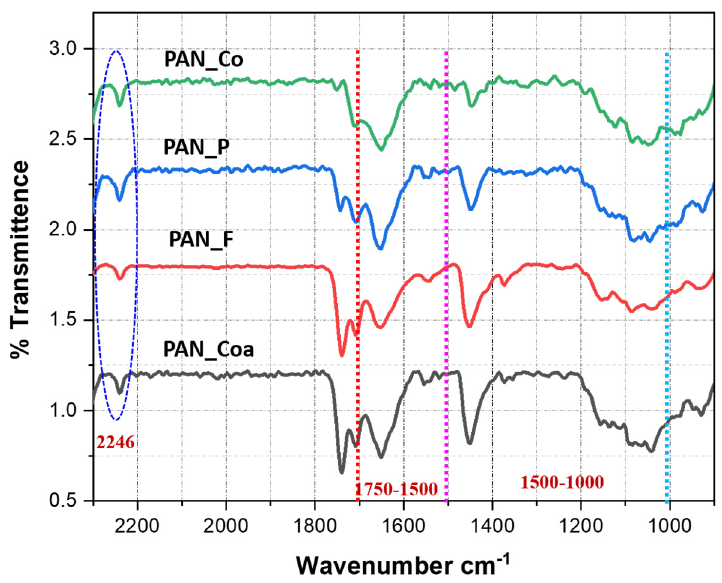
Figure 3. ATR-IR spectra of the PAN_P, PAN-F, PAN-Co and PAN_Coa NFs membranes.